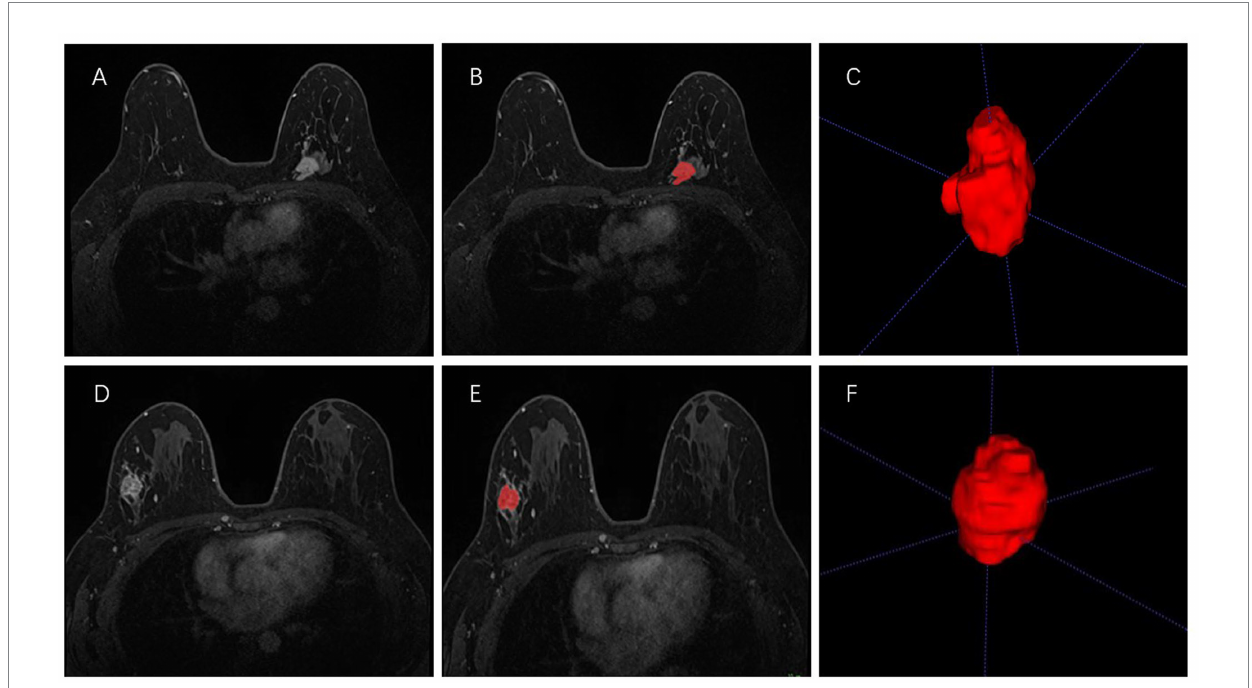
FIGURE 2 Manual 3-D segmentation of the tumor. (A–C) : a 58-year-old female diagnosed with the luminal A subtype of breast cancer. (D–F) : a 30-year-old female diagnosed with the triple-negative subtype of breast cancer. No special radiological features are seen by naked eye on MRI to distinguish between these two molecular